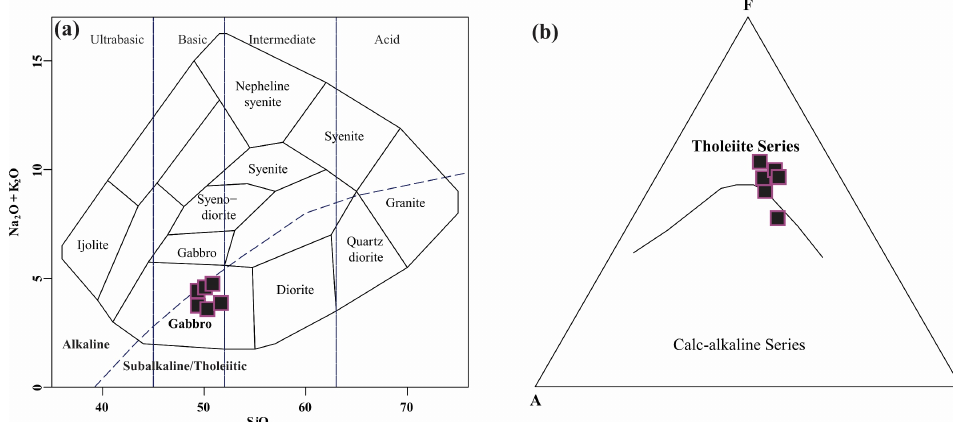
Figure 5. ( a ) TAS diagram [42]; ( b ) AFM diagram [43].